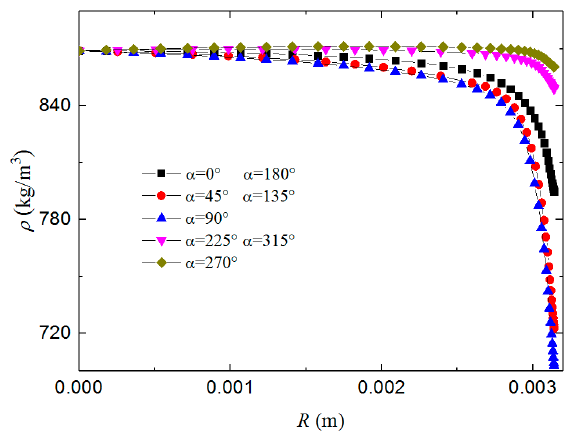
Figure 9. Case D2 density profile in the location of x/D=30 .